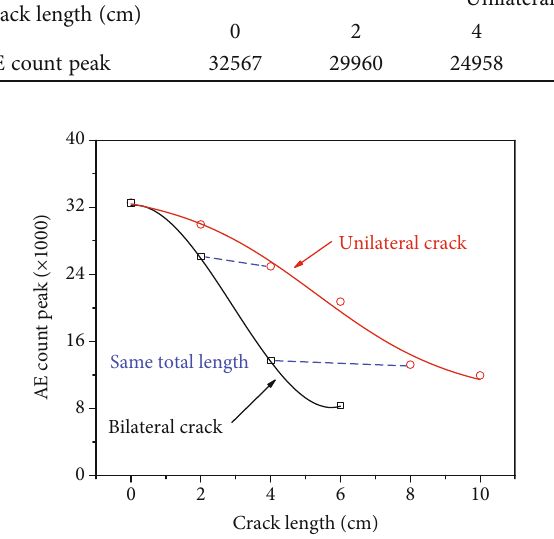
Figure 9: Fitting curves of peak value of AE count of specimens with di ff erent